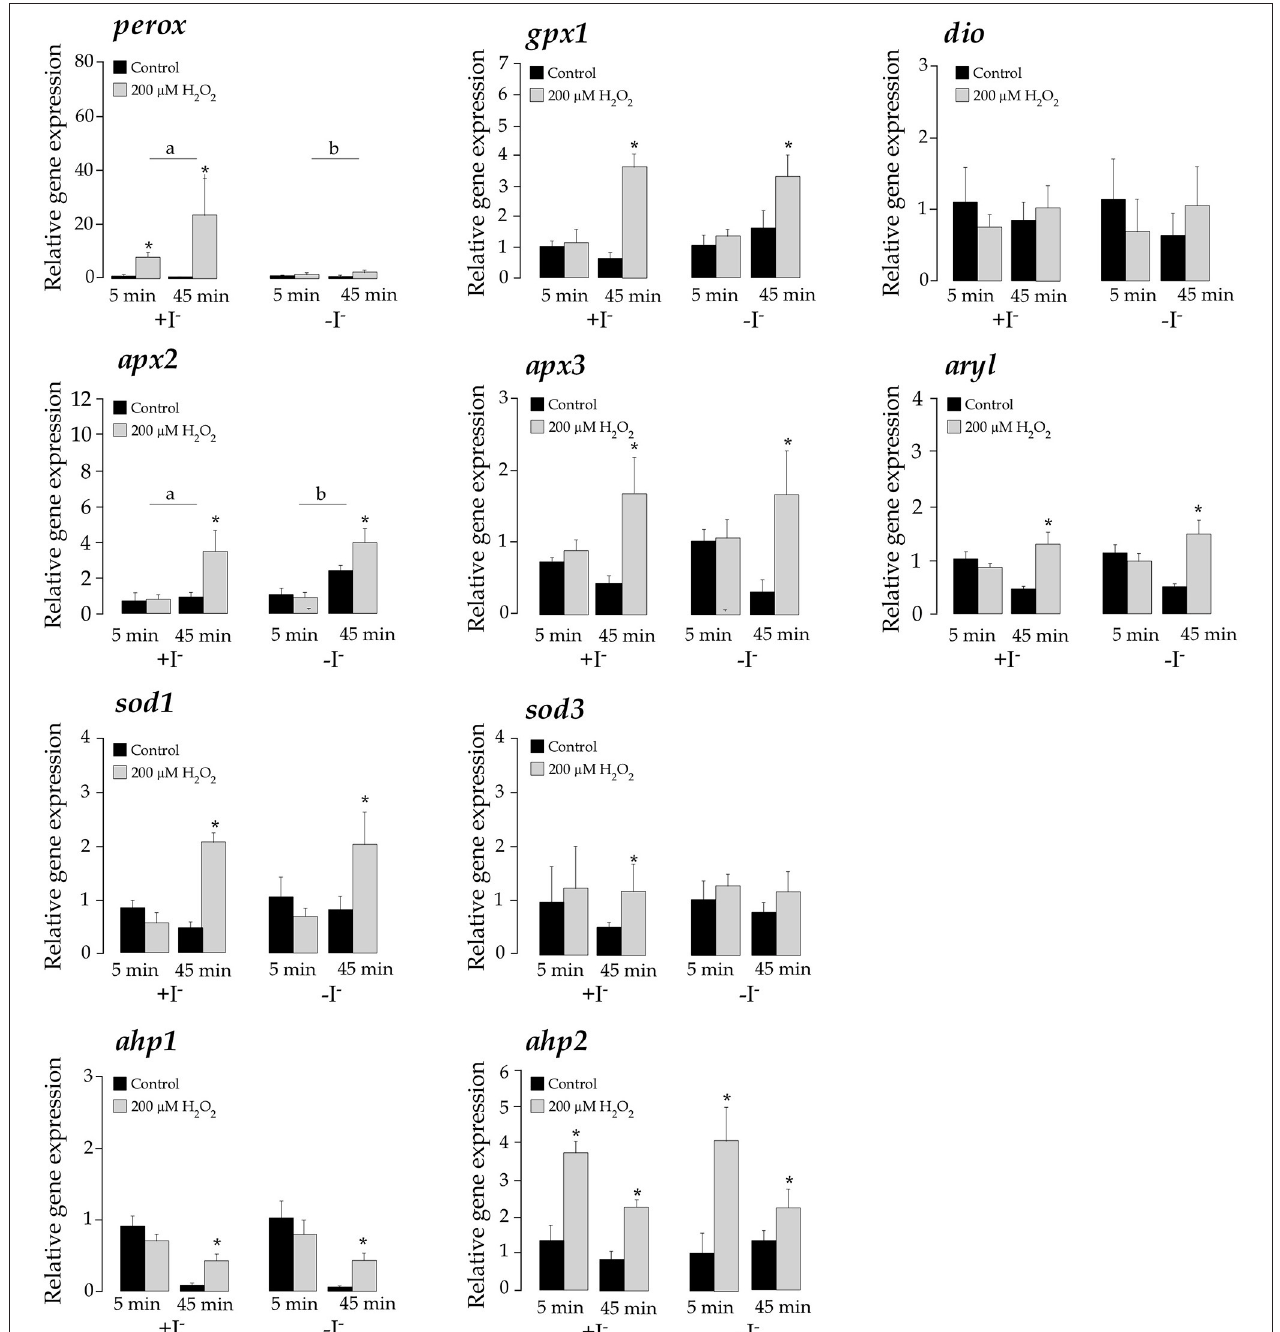
FIGURE 6 | Expression levels of perox , gpx1 , dio , apx2 , apx3 , aryl, sod1 , sod3 , ahp1, and ahp2 in T. lutea cultures at 5 and 45min after adding iodide ( + I − ) or not (–I − ) followed by a H 2 O 2 treatment (200 µ M). Negative controls without H 2 O 2 treatments were also done for each iodide concentration. Data represent the mean ± SEM. The asterisk denotes statistically significant differences between non-treated and H 2 O 2 -treated at each sampling point and iodide condition. The letters denote significant differences between iodide-added and non-iodide added samples. All data were calibrated to the 5min control samples added iodide without H 2 O 2